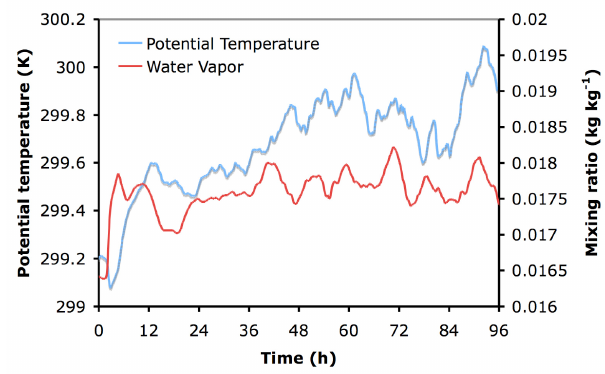
Fig. 18. Time series of the average potential temperature and water vapor mixing ratio within 100km of the center, at z = 305 m, for Experiment